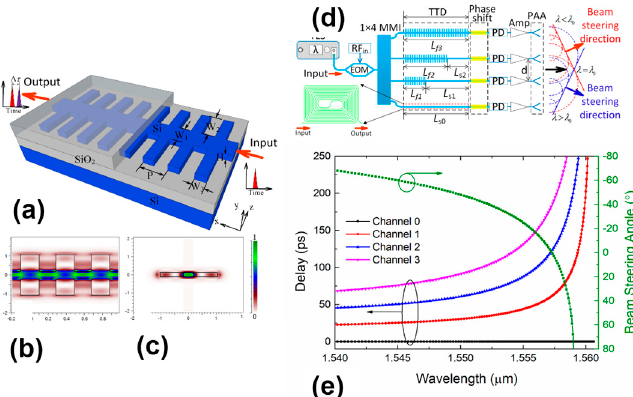
Figure 11. ( a ) Schematic configuration of the proposed 1D grating waveguide reported in [96]; ( b ) the electric field intensity distribution of the mode in the xz plane and ( c ) in the yz plane. ( d ) Wavelength continuously tunable beam steering system based on the 1D grating waveguide true time delay (TTD) lines. Amp: amplifier. Inset: schematic of the enlarged spiraled strip waveguide. ( e ) Delay time and beam steering angle versus wavelength for all four channels. The lengths of 1D grating waveguides are 0 mm, 1 mm, 2 mm, and 3 mm corresponding to channel 0, channel 1, channel 2, and channel 3. Courtesy of Jianyi Yang [96].